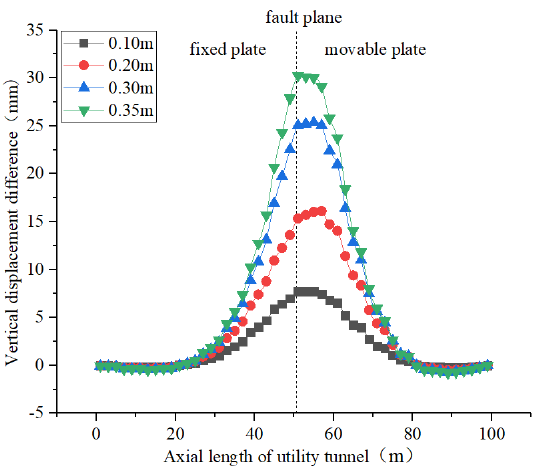
Figure 7. Vertical displacement difference distribution curve.